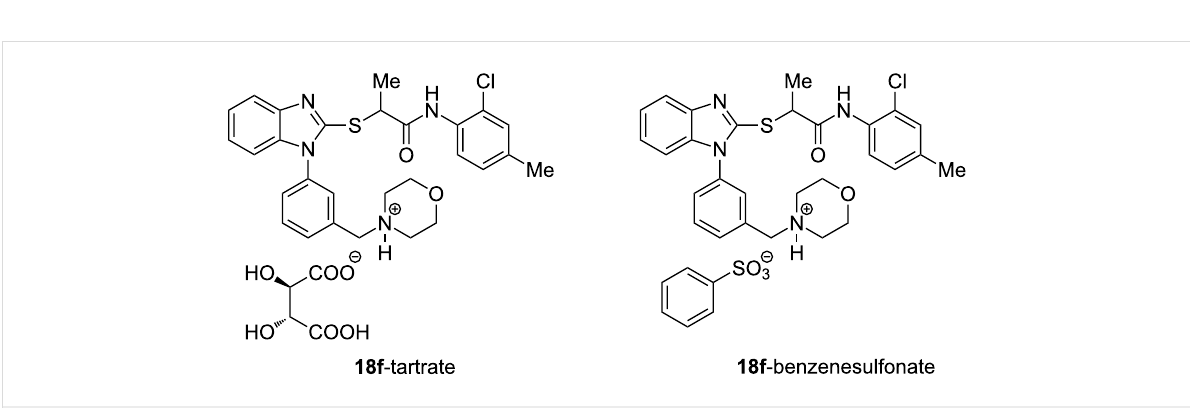
(3-(4,5-dimethylthiazol-2-yl)-2,5-diphenyltetrazolium bromide) as a surrogate for general cytotoxicity, reported here as CC 50